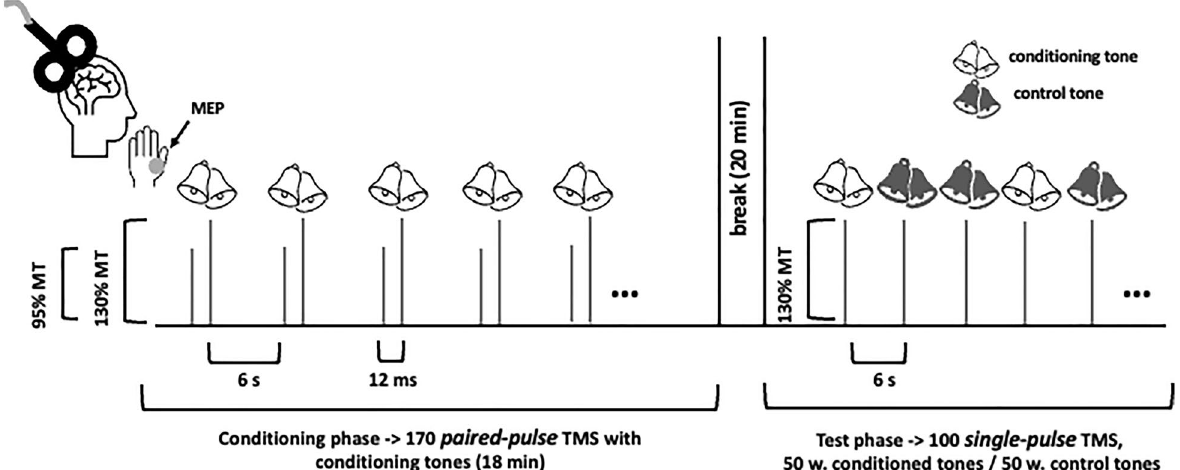
Figure 1. Experimental design. Over the conditioning phase, we applied 170 faciliatory paired TMS pulses to the representation of the right abductor pollices breves muscle over the left primary motor cortex while recording muscle evokes potentials (MEPs) from the target muscle. The first (subthreshold) TMS pulse was adjusted to 95% passive motor threshold (MT), the second (suprathreshold) pulse to 130% passive MT. To induce a faciliatory effect, inter-stimulus interval (ISI) between both TMS pulses was set to 12 ms. Each first subthreshold pulse of each paired-pulse TMS application was paired with one out of two acoustic stimuli (830 Hz or 1480 Hz, counterbalanced across participants). The Intertrial intervals was 6 s long. The conditioning phase was 18 min long. 20 min after the conditioning phase, the test phase started. In the test phase, we applied 100 suprathreshold single TMS pulses with the same 130% MT as used for the second TMS pulse during the conditioning phase. Fifty single TMS pulses were paired with the conditioned tone (white bells) and 50 with the control tone (dark bells). Their order was chosen pseudorandomly. The tone and the single TMS pulse were presented simultaneously as during the conditioning phase. Like in the conditioning phase, inter-trial intervals were set to 6 s. The statistical comparison of single-pulse TMS MEP amplitudes paired with the conditioned tone vs. control tone was used to assess successful